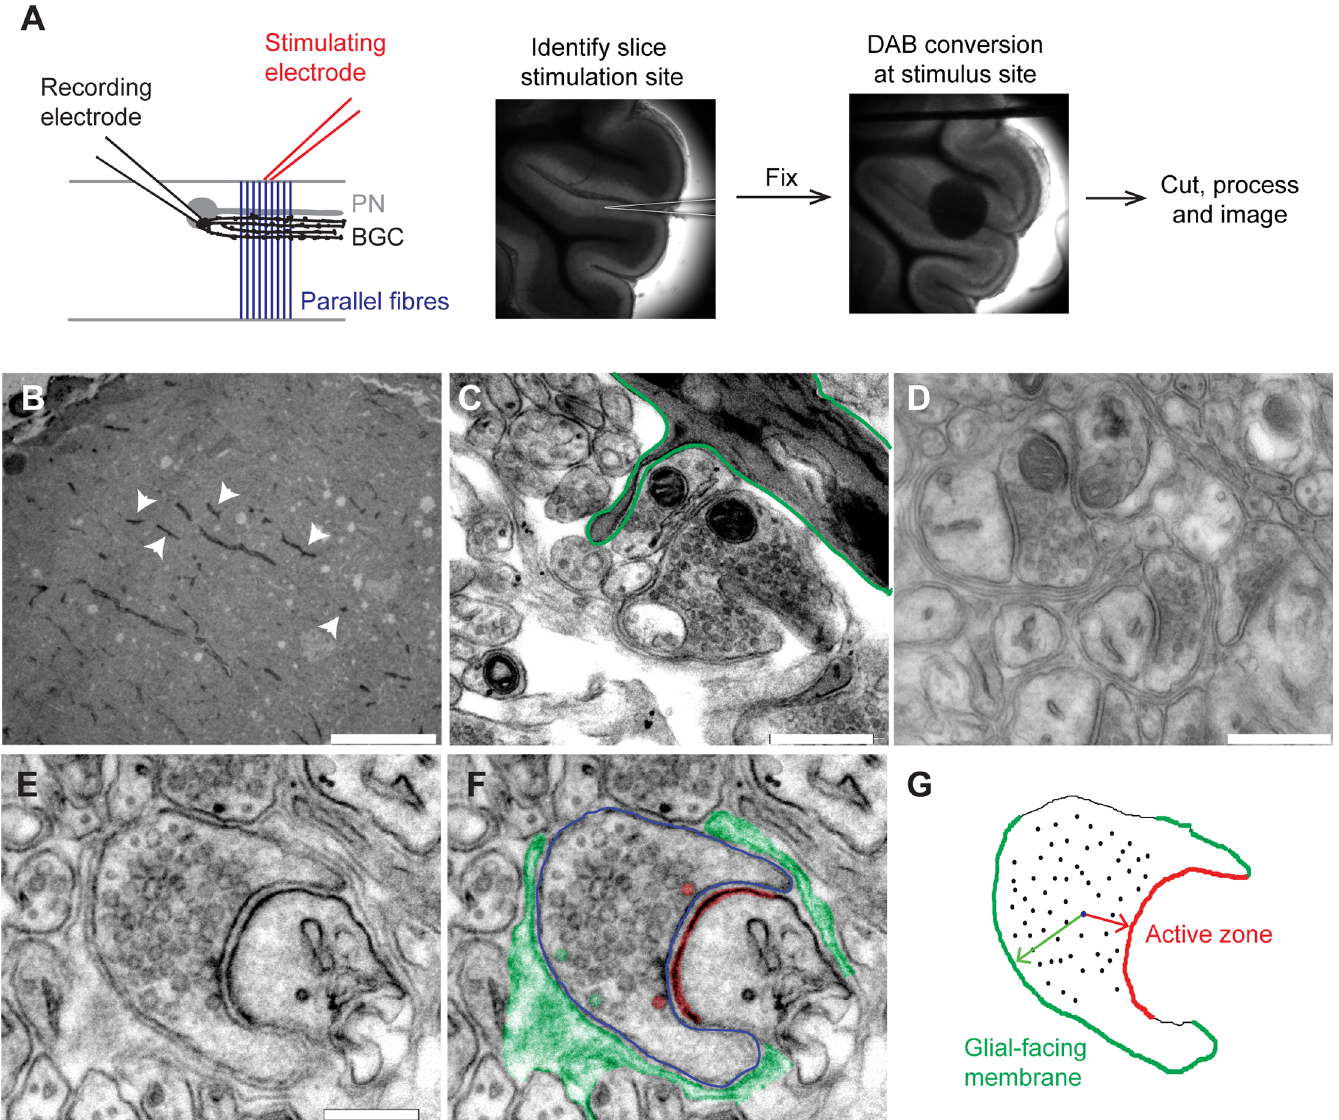
Fig 1. Analysis of vesicle distribution in presynaptic terminals. A) Illustration of recording and stimulation configuration. A Bergmann glial cell (black) was recorded with whole-cell patch clamp technique, with an internal solution containing 1 mg/ml Lucifer yellow. A stimulating electrode was placed in the centre of the molecular layer to activate parallel fibres (blue). B) After DAB treatment and photoconversion, electron-dense fibres in the molecular layer (arrow heads) confirm the recording and stimulation site. Scale bar = 25 μm. C) Bergmann fibres with electron dense deposits can be observed at higher power (green outline) and used to orient analysis to the stimulated region of the molecular layer. Scale bar = 500 nm D) Individual presynaptic terminals can be identified within the stimulated region. Scale bar = 500 nm. E) Individual terminals were isolated, contrast-adjusted and used to assess vesicle distribution. Scale bar = 150 nm. F) Manual labelling of presynaptic terminal (blue line), extrasynaptic glial processes (green fill) and postsynaptic density (red fill) was carried out for each terminal. In this case, vesicles located close to the active zone (red fill) or glial facing membrane (green fill) were visible. G) After manual labelling of structures, the centre of each visible vesicle was marked as a point. Export of the coordinates from imaging software allowed reconstruction of the terminal in Matlab. For every vesicle (black dots), the shortest distance to the nearest glial facing membrane (green) and active zone (red) was calculated.